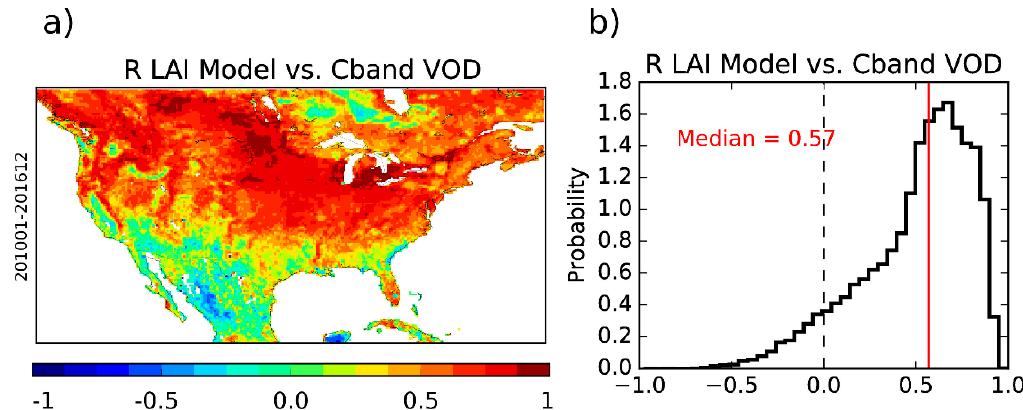
Figure 12. ( a ) Correlation coefficient values between modelled LAI and C-band vegetation optical depth (VOD) over 2010–2016, ( b ) probability distribution of the correlation coefficient values over the same period.